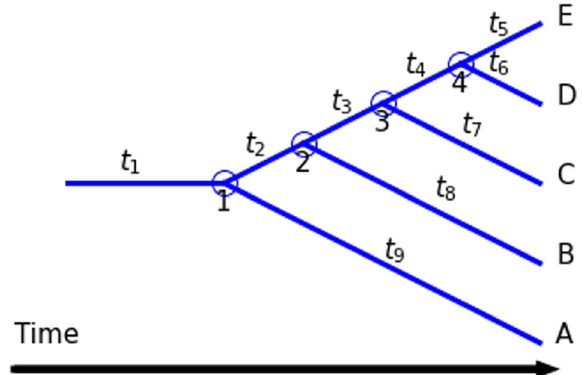
Fig. 2 A phylogenetic tree displaying the relationship between fi ve cultures. The tree shows the relationship between fi ve hypothetical cultures. The most time-distant split was between A and the common ancestor of B, C, D, and